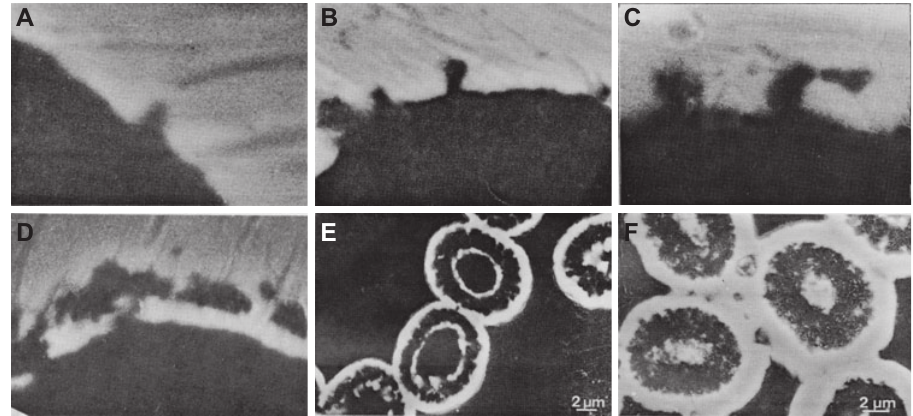
Figure 3 Scanning electron micrographs of the incubation stage and the migration of the nickel ring. Deterioration of the carbon fi ber cor- responds to the graphitization by the Ni ring.